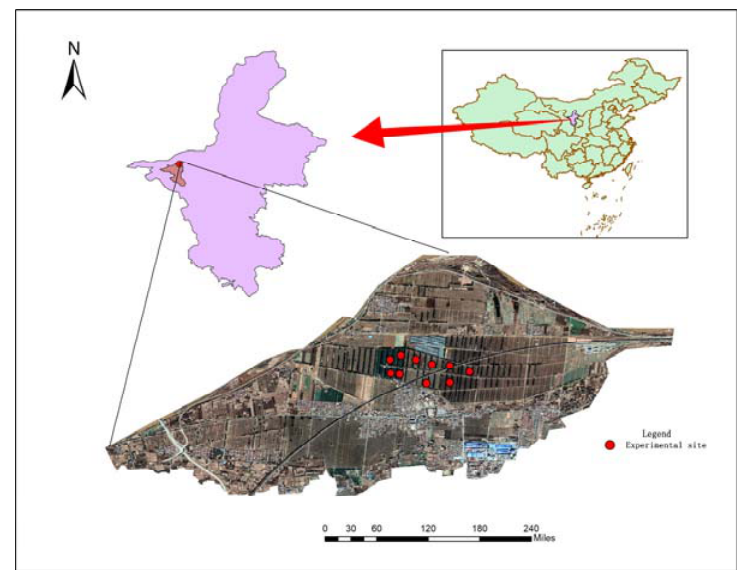
Figure 1. Study area location and experimental sites within PR China.